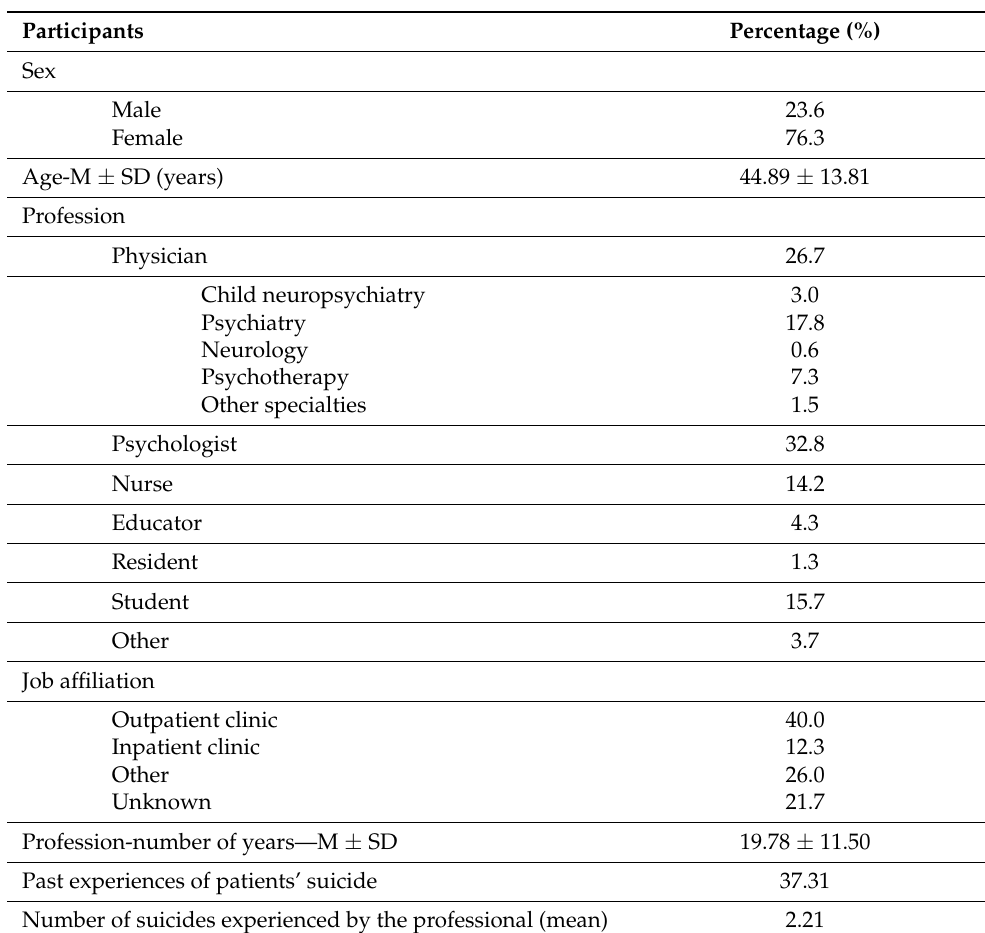
Table 1. Characteristics of the